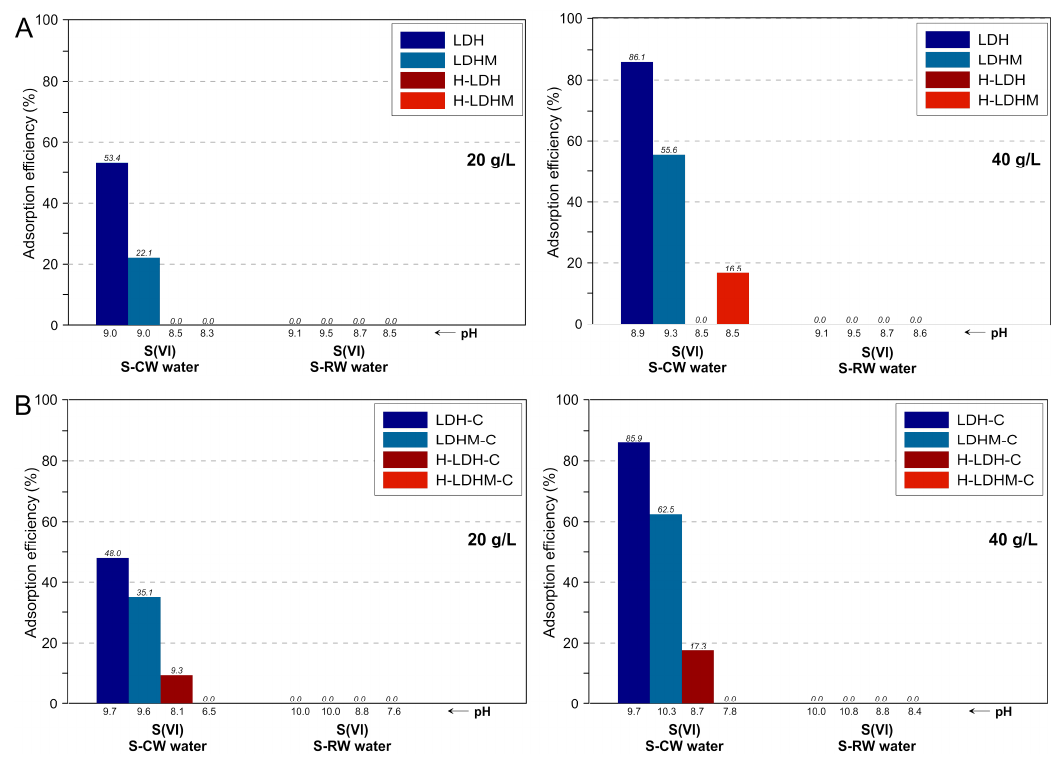
Figure 8. Comparison of S(VI) removal from multi-element systems versus adsorbent doses: ( A ) uncalcined materials and ( B ) calcined materials.